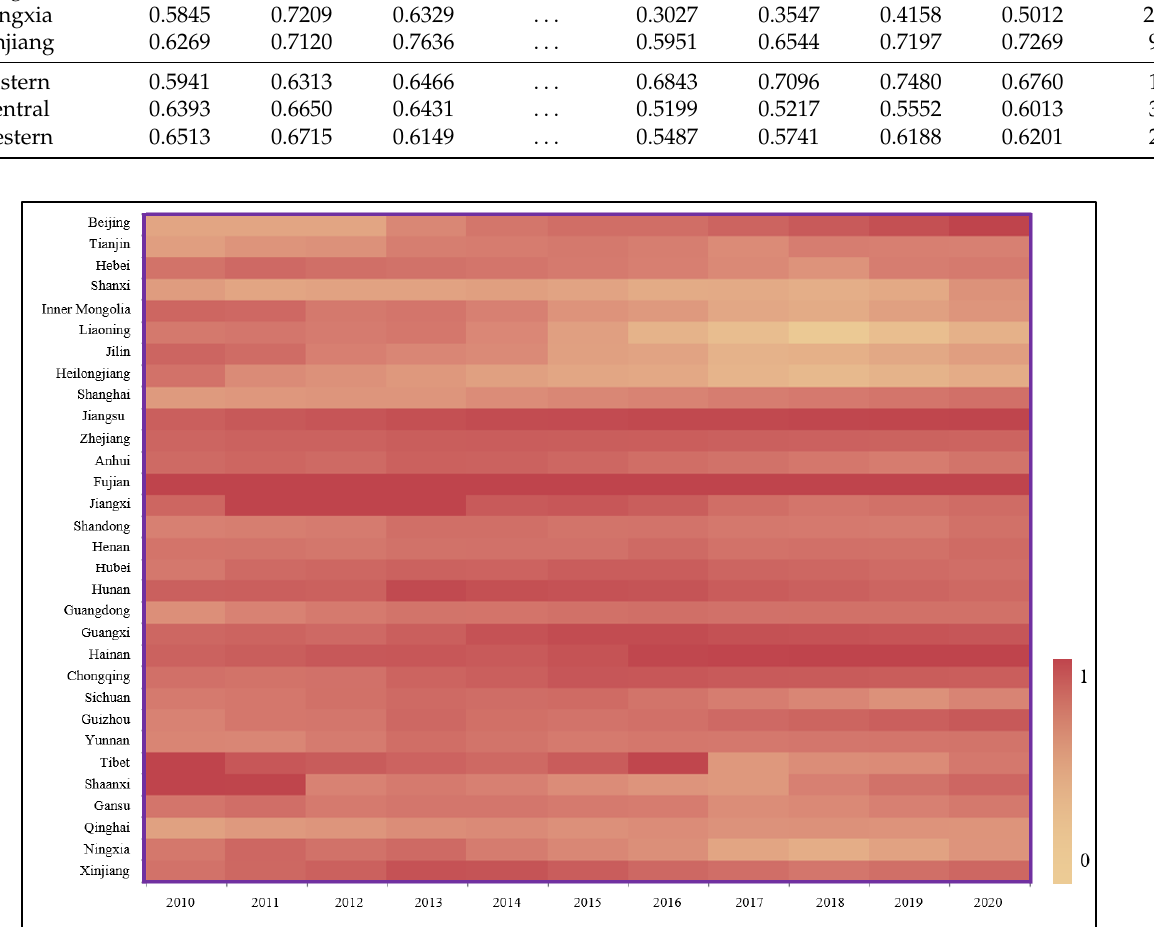
Figure 5. Heat map of the comparative production efficiencies of the construction industry in 31 provinces in China.